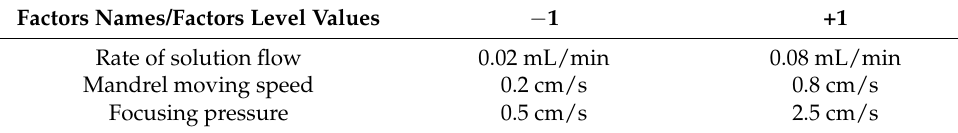
Table A1. Table of factor level values.